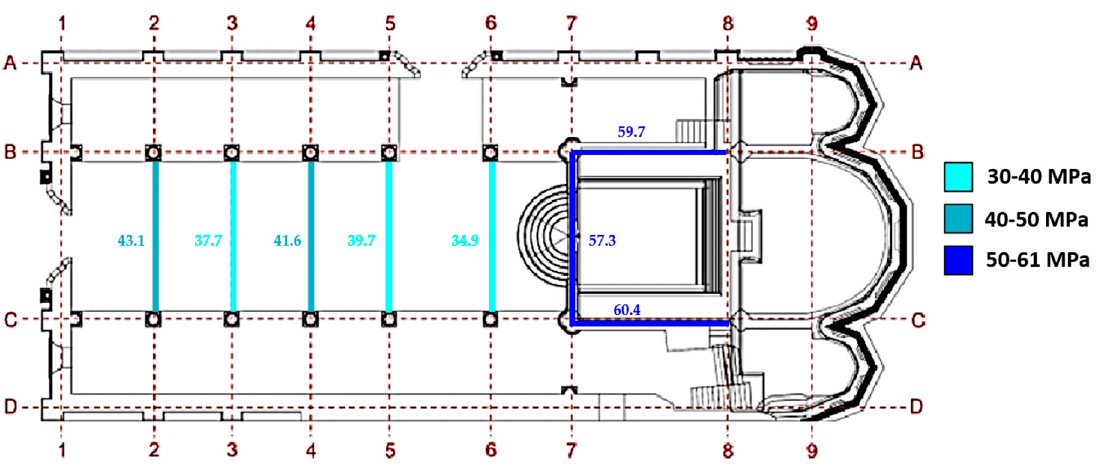
Figure 14. Stress levels measured on the tie rods in the Cathedral of St. James in Šibenik at level R4.